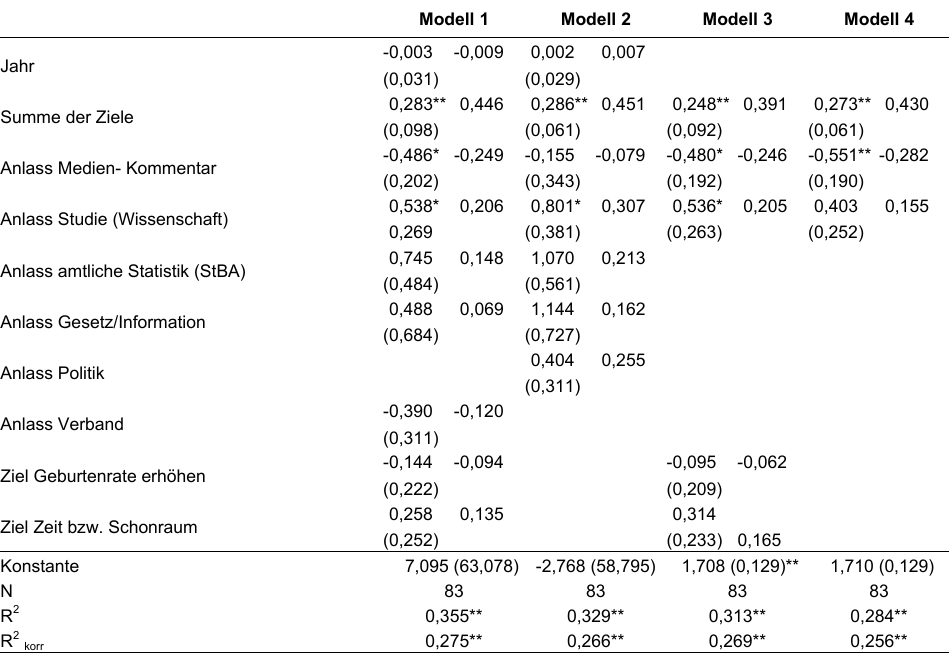
Tabelle 1 : OLS-Regressionsanalyse zu Determinanten der Valenz von Zeitungsartikeln zum Elterngeld 2004-2012 Modell 1 Modell 2 Modell 3 Modell